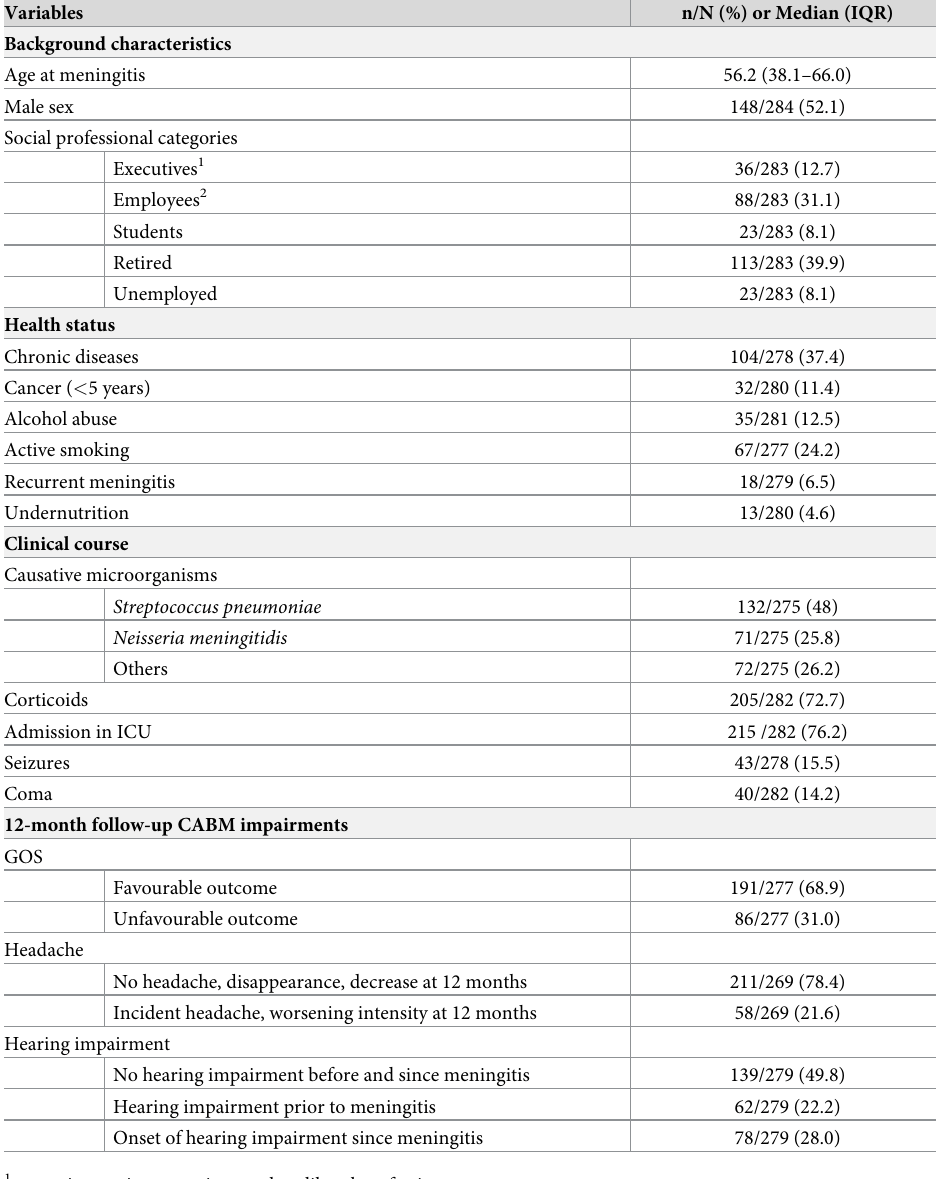
Table 1. Baseline characteristics at admission, CABM 12-month impairments, COMBAT France,